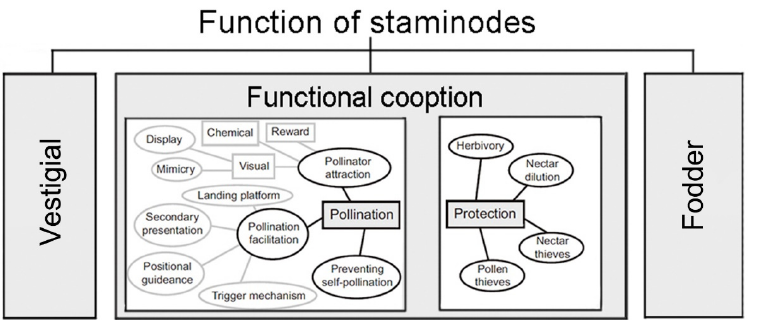
Figure 1. A schematic classification of staminodes based on evolutionary history and function. The staminodes are classified into three major groups based on their evolutionary history: vestigial, fodder, and functional cooption (modified from [19]).